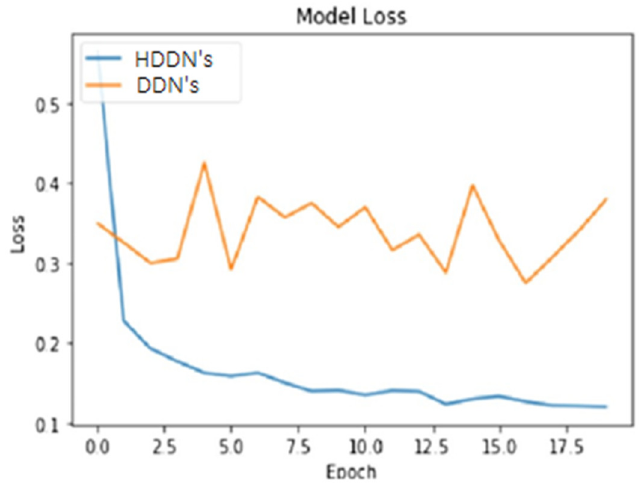
Figure 5. Loss of COVID-19 dataset against the number of COVID-19 CT and chest X-ray samples for the deep neural network (DNNs) and hybrid deep neural network (HDDNs).